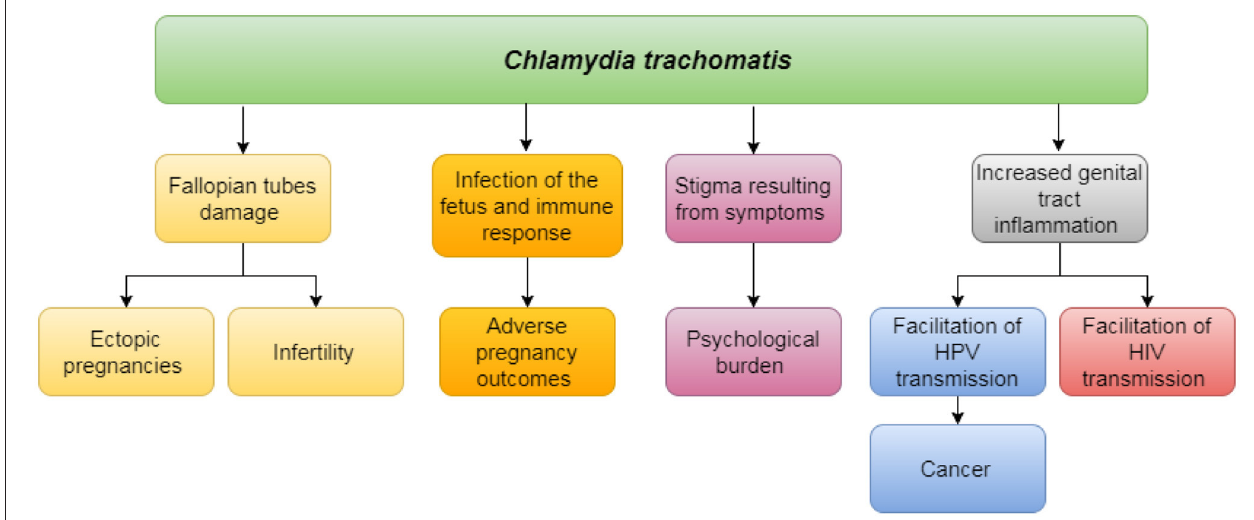
FIGURE 1 | Impact of untreated Chlamydia trachomatis on individual’s